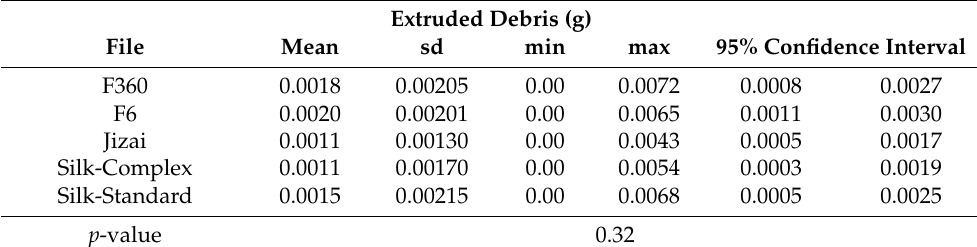
Table 3. Amount of apically extruded debris (g) after preparation with the different instruments ( n = 20/group). Given are the means with standard deviation (sd), the minimum and maximum values, and the 95% confidence interval. No statistically significant differences were obtained between the different